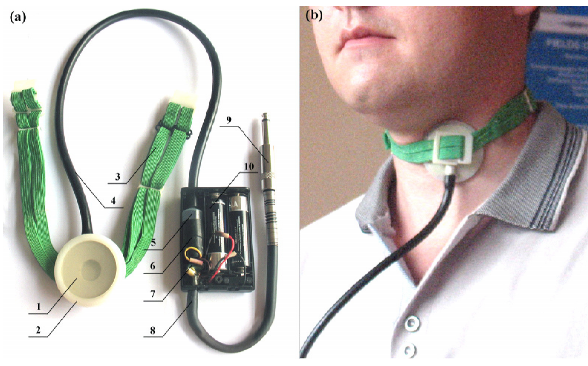
Figure 3: Throat microphone of phonendoscopical type. (a) Struc- ture: 1 - membrane; 2 - sound-detecting chamber; 3 - fixing belt; 4 - flexible air pipe; 5 - hollow cylinder with cone for mounting the flex- ible air pipe; 6 - electret microphone; 7 - device for interfacing the electret microphone with signal line; 8 - audio cable; 9 - audio TRS- connector; 10 - electric batteries. (b) Fixation of throat microphone on speaker’s neck near the larynx.